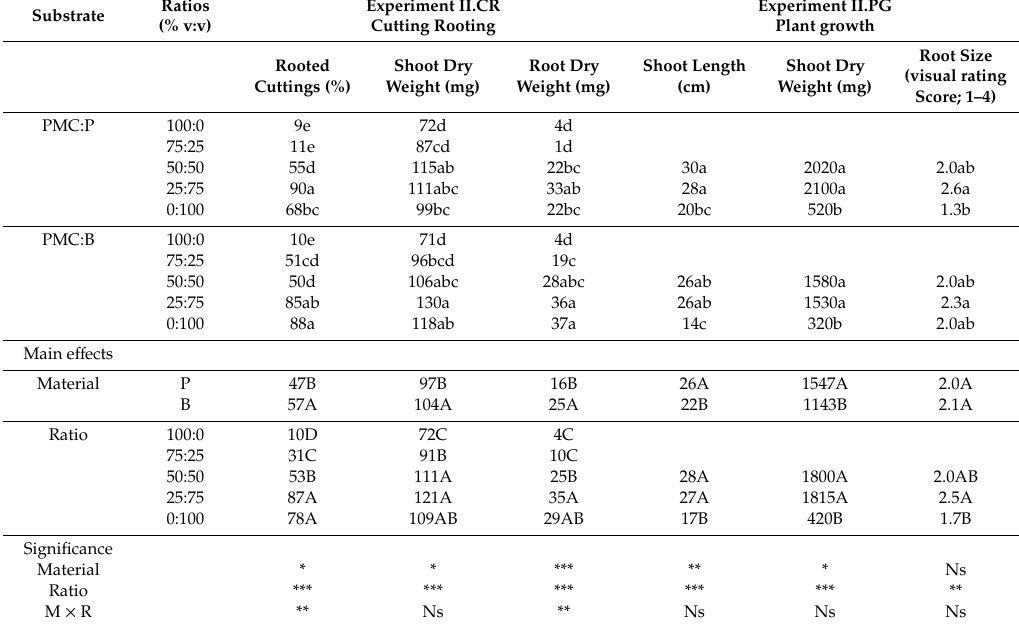
Table 5. Cutting rooting (experiment II.CR) and plant growth (experiment II.PG) of Rosmarinus o ffi cinalis as a ff ected by growth media containing poultry manure compost mixed with peat (P) or biochar (B) at di ff erent ratios. Main e ff ects and statistical significance according to factorial analysis of variance. Three replicates (n = 3) were used for each substrate and